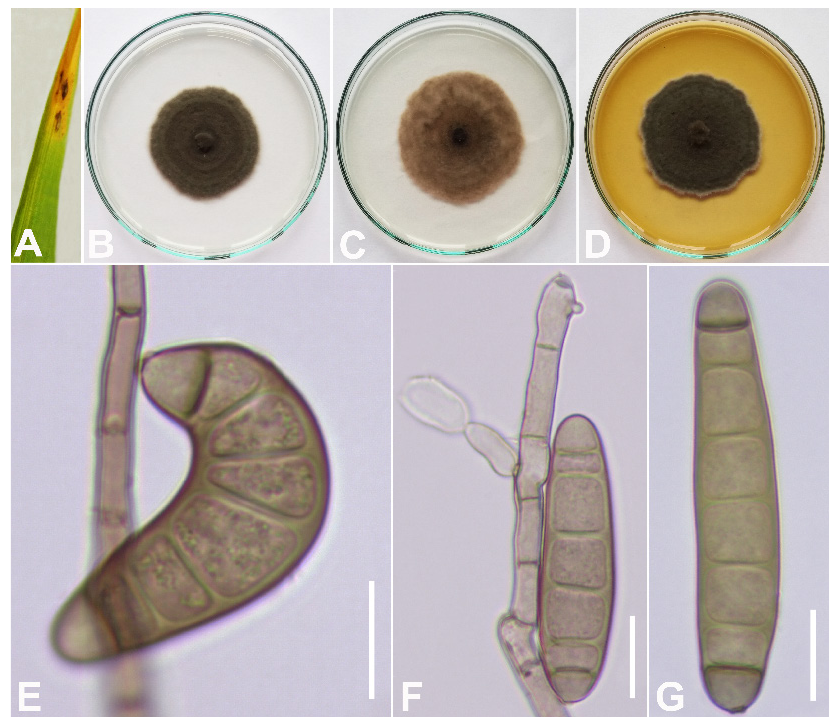
Figure 3: Morphological characters of Exserohilum rostratum (isolate USJCC–0011). A. Lesions on host Oryza sativa . B. 7-d old colony on PDA C. 7-d old colony on CMA D. 7-d old colony on MEA. E–G. Conidia. (Scale bars: E–G = 10 μm). green with mouse grey center, irregular margins, attaining approximately 6.9 cm diam.; on CMA dull green aerial mycelia, convex, approximately 5.8 cm in